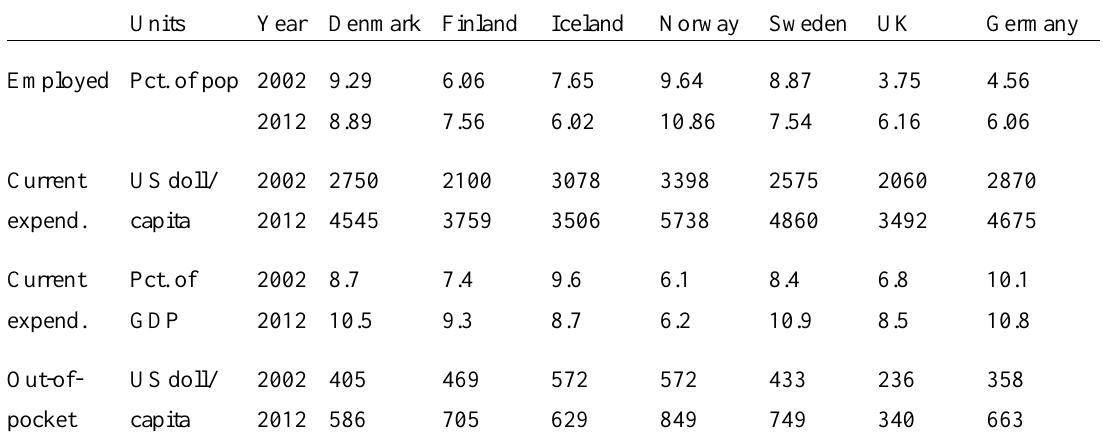
705 629 849 340